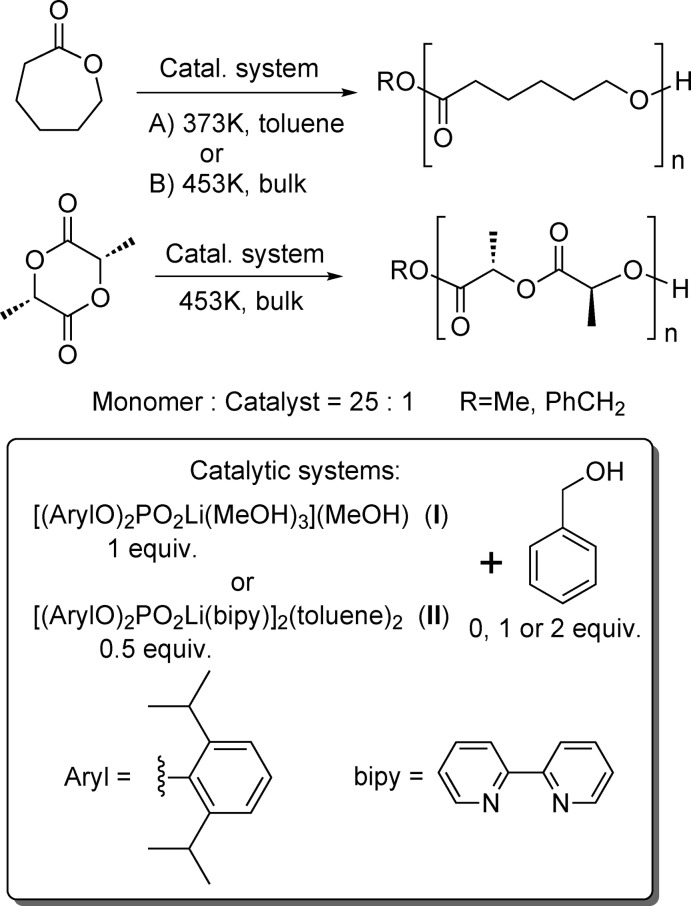
Ring-opening polymerization of ∊-caprolactone and l-dilactide using complexes {[(2,6-iPr2C6H3O)2PO2]Li(MeOH)3}(MeOH), (I), and {[(2,6-iPr2C6H3O)2PO2]Li(bipy)}2(C7H8)2, (II).